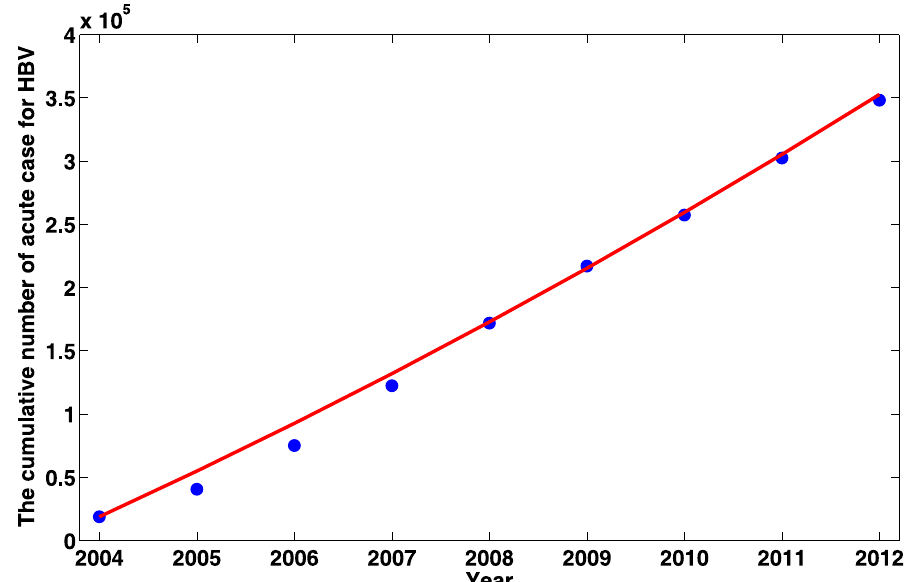
Fig 4. The comparison between the cumulative number of acute HBV case from 2004 to 2012 and the simulation of our model. The discrete points represent the data reported by public health science data center while the solid curve is simulated by using our model.